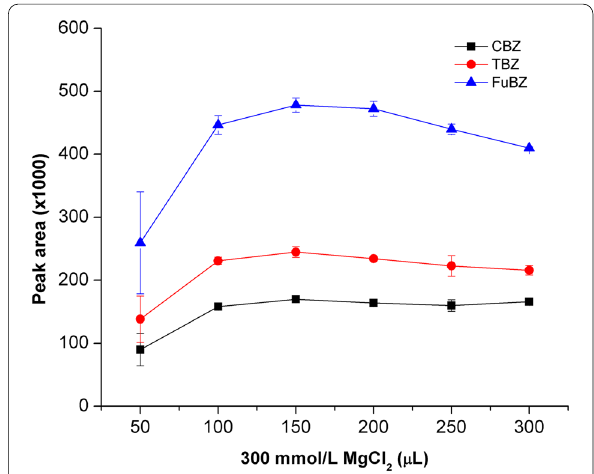
Fig. 4 Effect of SDBS concentration on the extraction performance of target fungicides (100 µg/L each). Conditions: 300 mmol/L MgCl